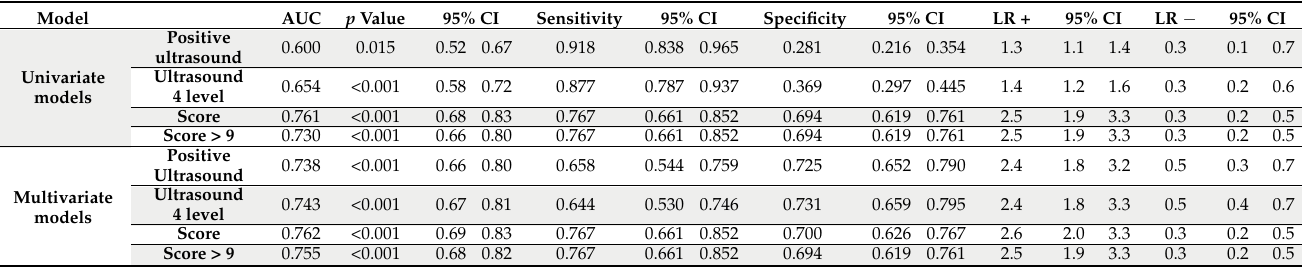
Table 5. ROC Models. Univariate and multivariate